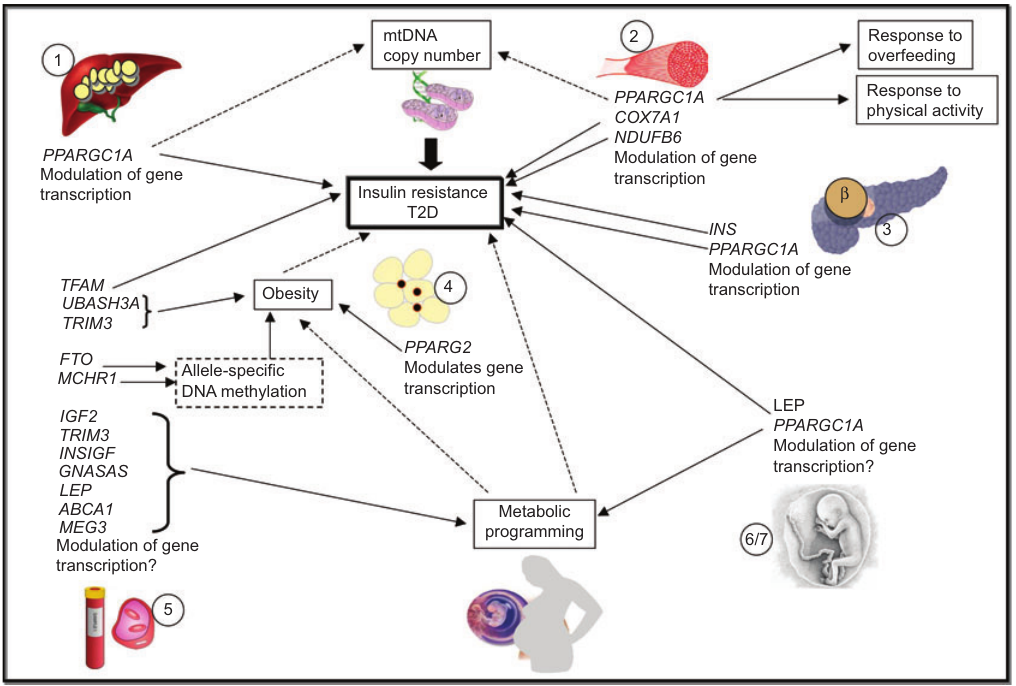
Figure 1 Role of DNA methylation status of target genes in the development of human IR- and MS-related phenotypes: summary of current